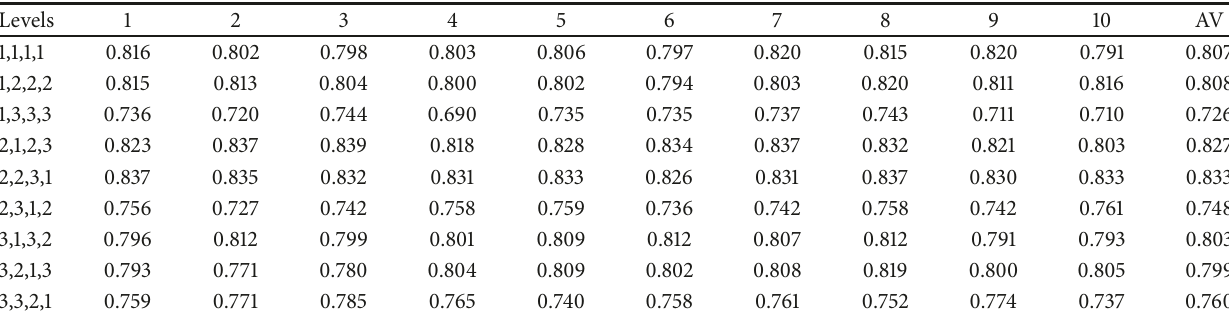
Table 5: Experiment response results (Sea dataset, Inc-GEP2 classifier).